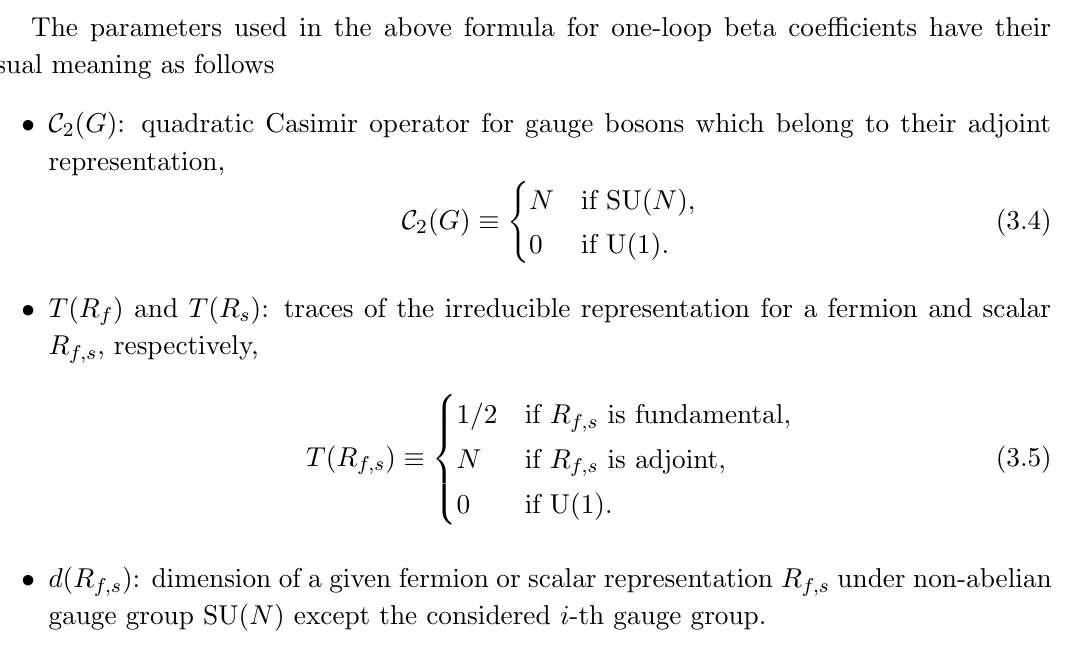
10 6 GeV (cid:25)